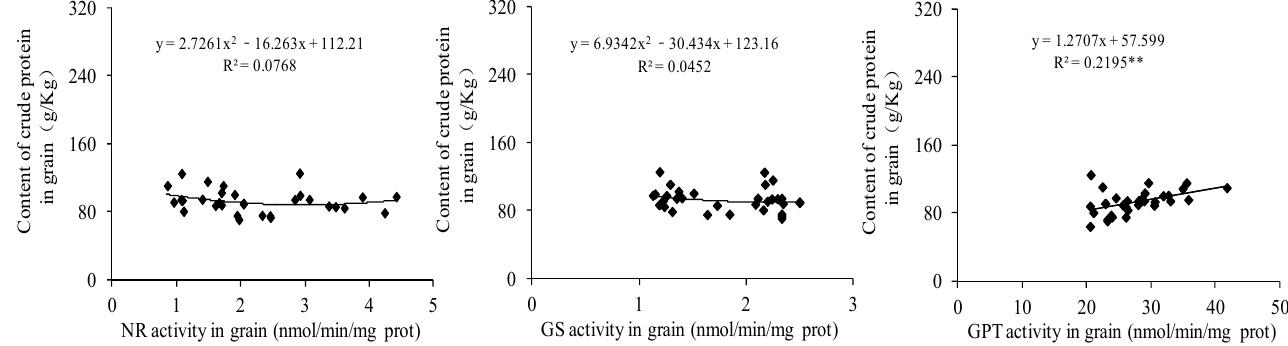
GPTactivity in grain (nmol/min/mg prot) Figure 13. Relationships between crude protein content and key enzyme activity in grain. Note: “**” indicate a significant correlation at the 0.01 probability level. The dots represent the measured val- ues, and the lines represent the correlation trend in the figure.